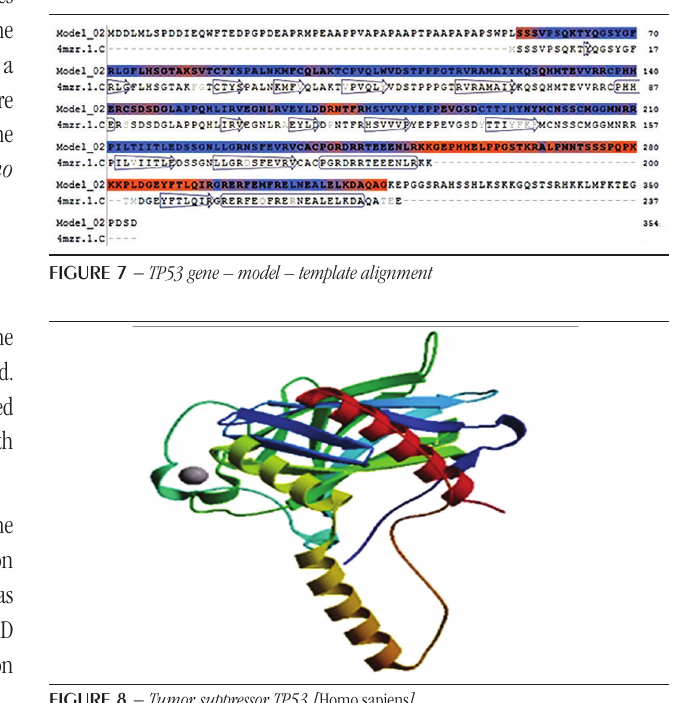
figurE 6 − PTEN protein